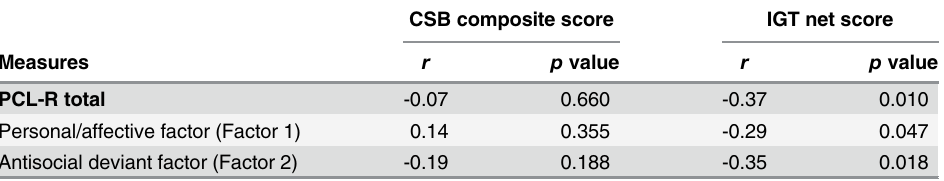
Table 2. Partial correlations between scores of measures on violence risk and neuropsychological performances in healthy controls. CSB composite